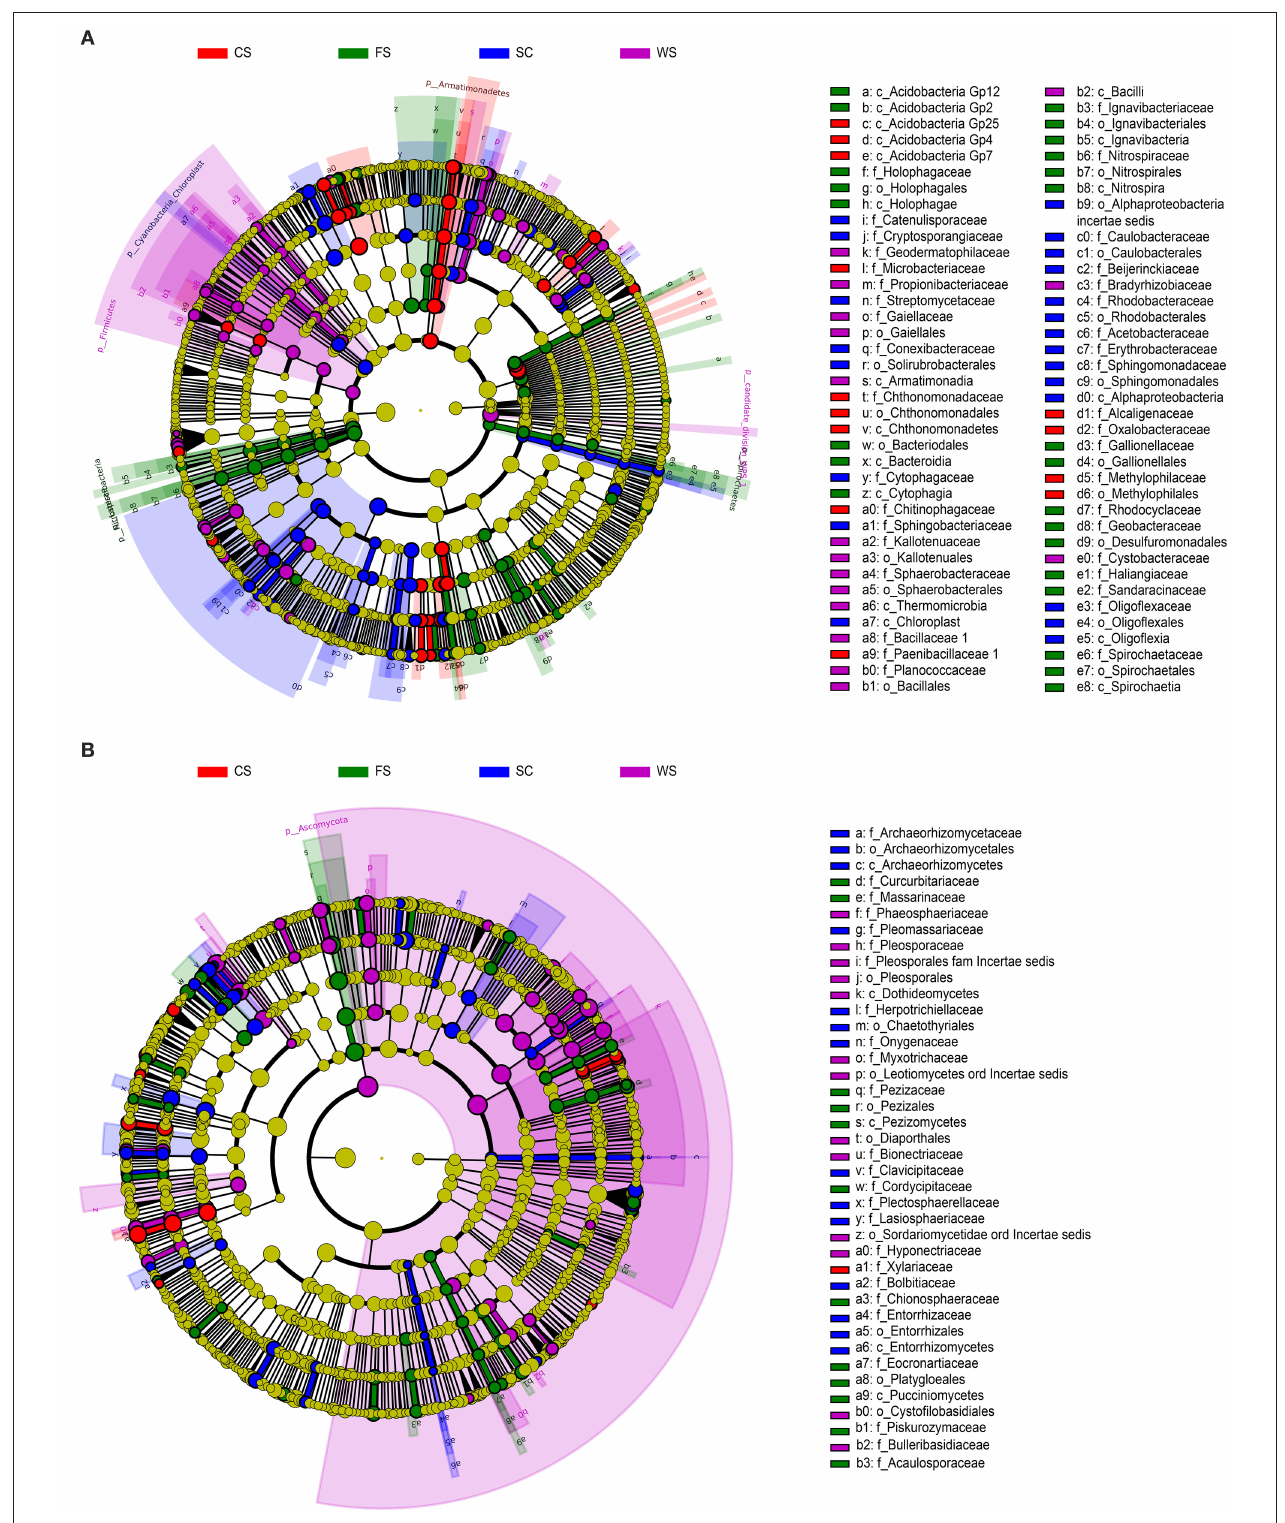
FIGURE 3 | Analysis of significant species. (A) : bacteria. (B) : fungi. (A,B) : LefSe. LefSe analysis diagram: the nodes indicate that the microbiota (with significant differences from the other groups) played an important role in the group, and the yellow nodes indicate the absence of significant microbial groups in the group. The